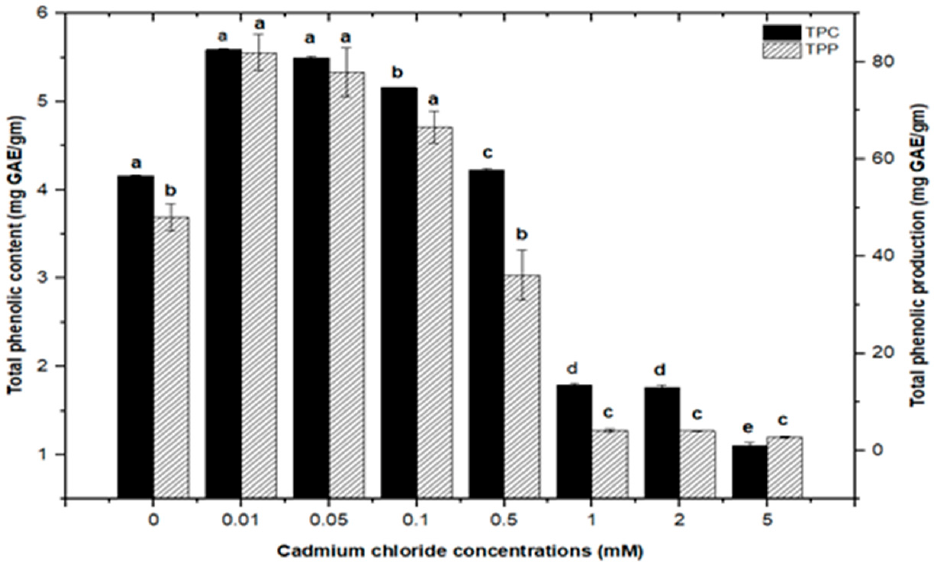
Figure 6. Total phenolic contents and phenolic production of F. indica calli elicited with seven different concentrations of cadmium chloride and control. All the values are mean ± SE. Bars labeled with different letters (LSD values) exhibit significant variation ( α < 0.05).